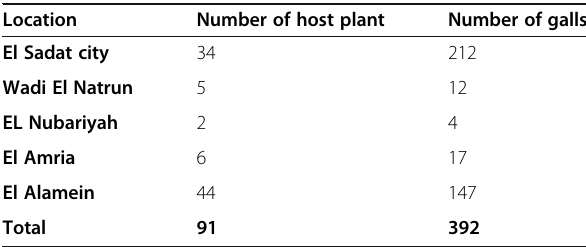
Table 3 Gall induction on Deverra tortuosa within the